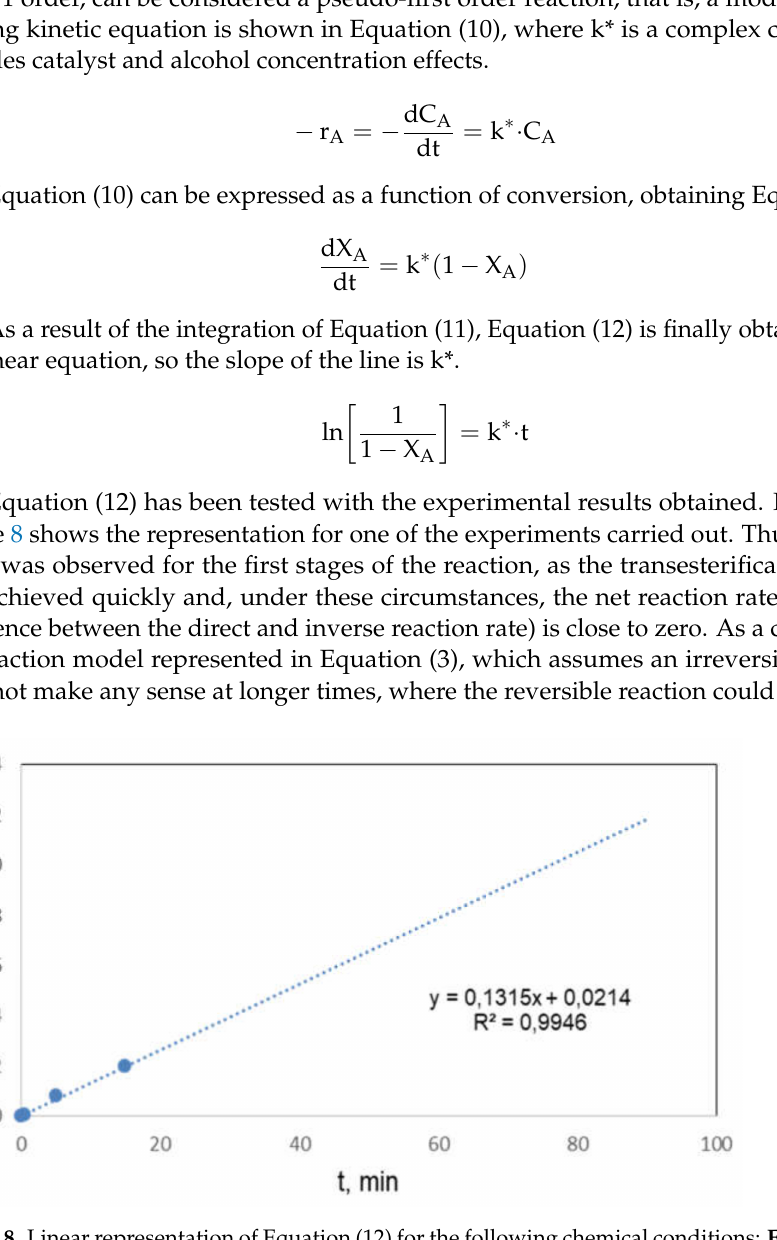
Figure 8. Linear representation of Equation (12) for the following chemical conditions: FAME/alcohol mole ratio, 1:1; catalyst concentration, 1.5% w/w ; temperature, 100 ◦ C; reaction time, 90 min; stirring rate, 500 rpm.